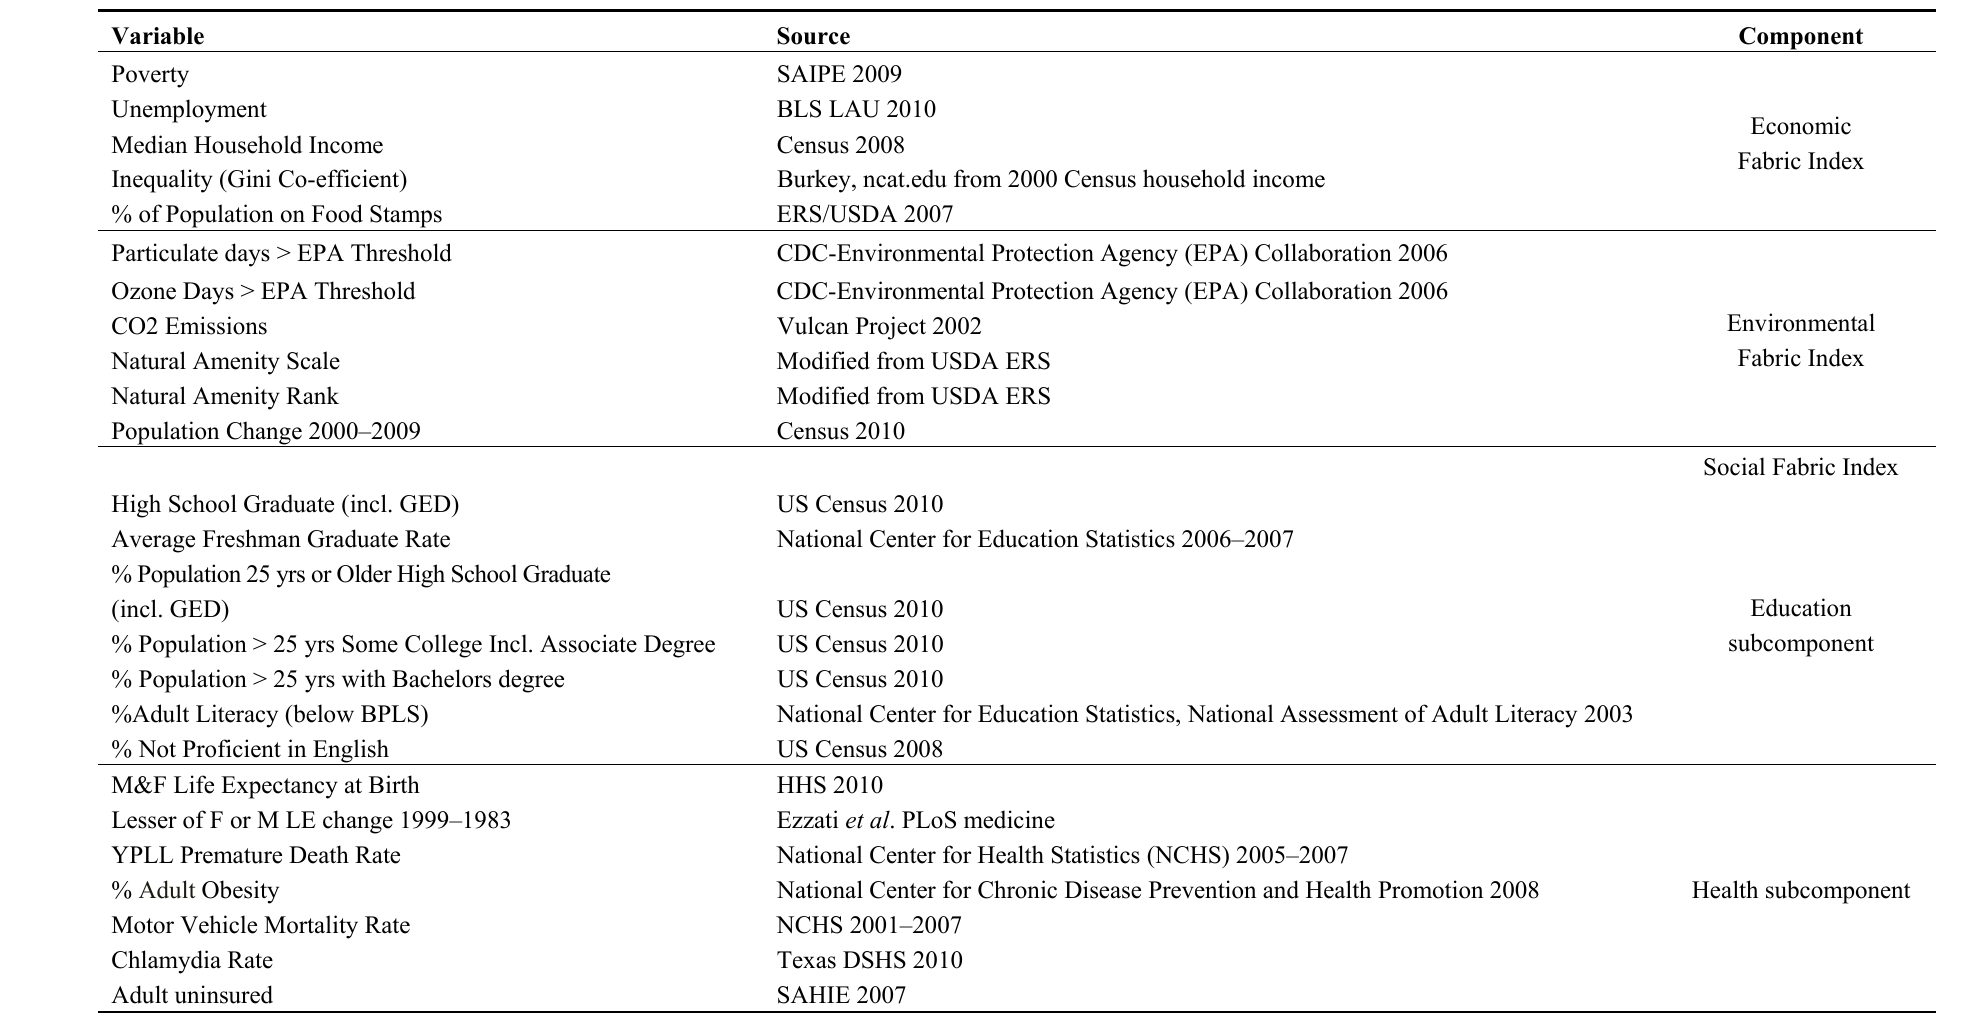
Table A1. Human Security Index (HSI) variables and